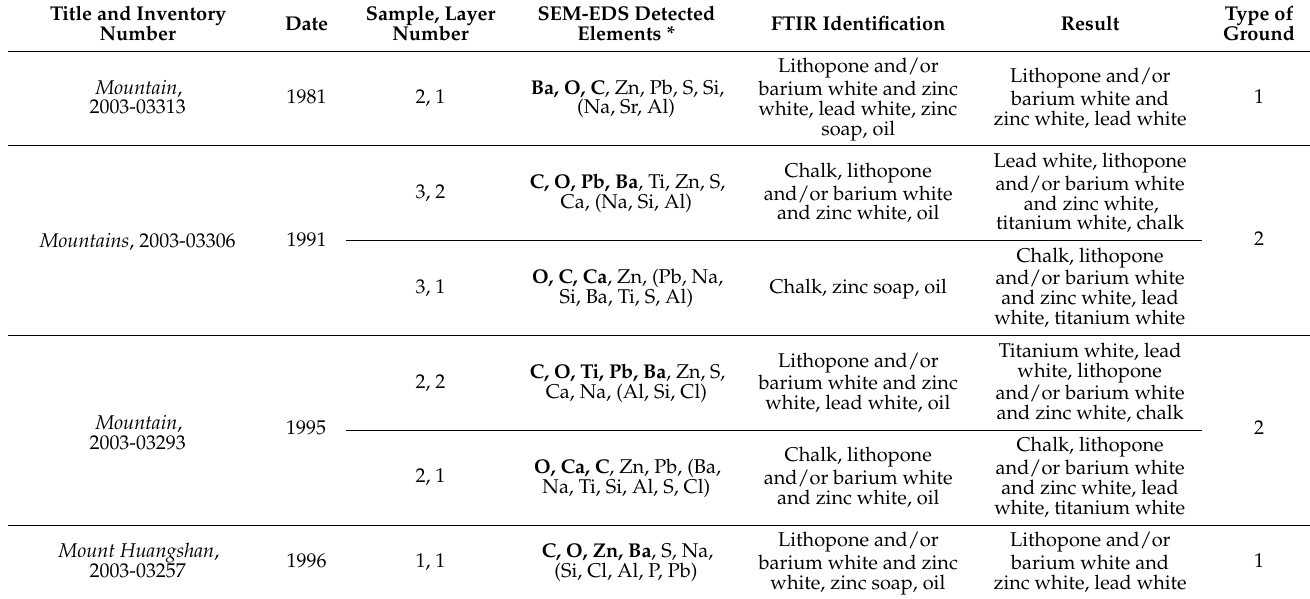
Table 3. Overview of the ground characteristics of the investigated paintings.